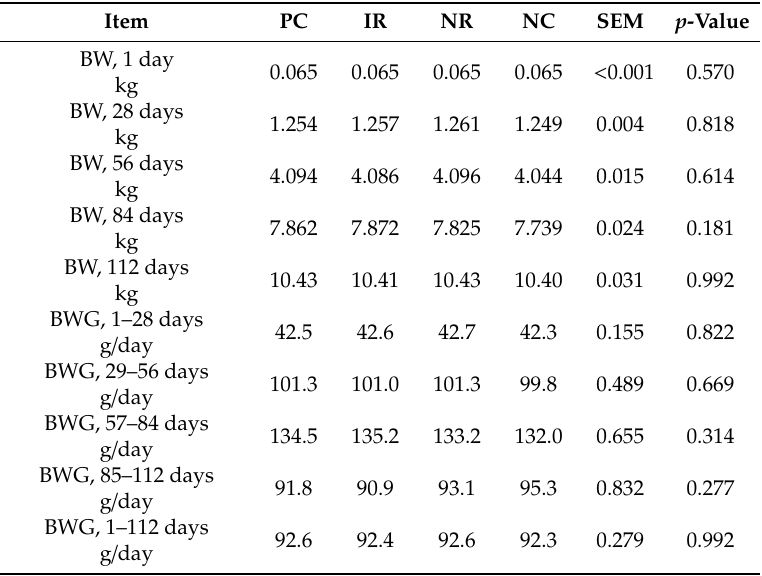
Table 2. Growth performance of